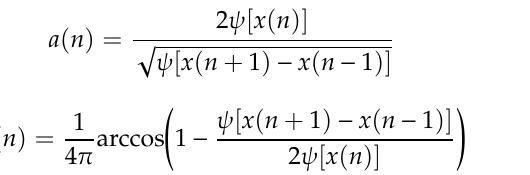
Figure 6. Flowchart of the parameter optimization of VMD using the GWO algorithm.